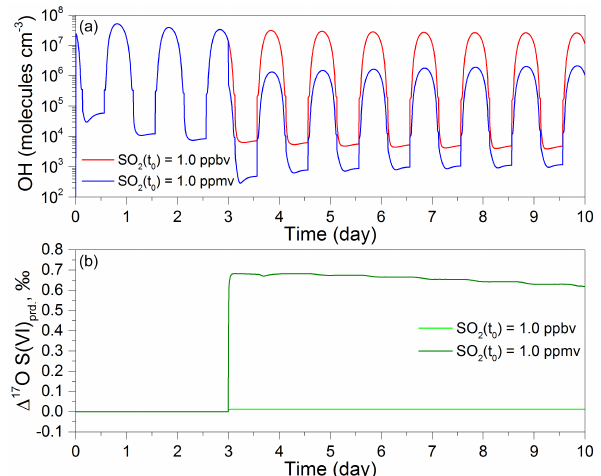
Figure 4. Time evolution of the O-MIF transfer from OH to H 2 SO 4 (g) at two different initial concentrations of SO 2 . The light green line represents initial concentration of S ( IV ) = 1ppbv (e.g. mean troposphere); the dark green line represents an initial concentration of SO 2 = 1ppmv (e.g. volcanic plumes and clouds). The upper figure shows concentration trends for OH during the two different scenarios.